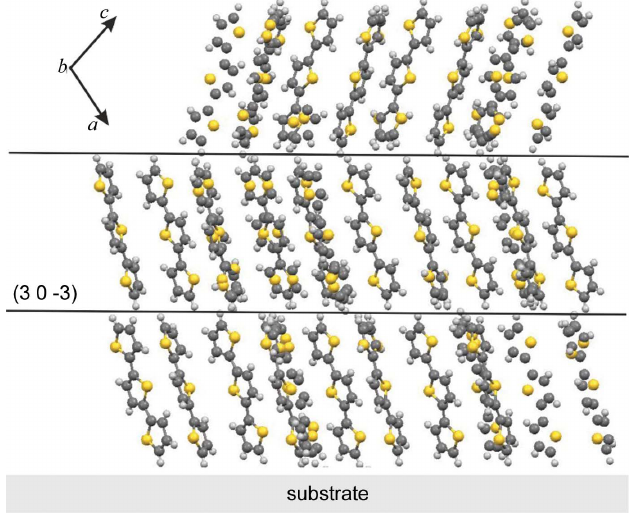
Figure 4 Arrangement of terthiophene molecules relative to the substrate surface within the surface-confined phase in a front view projected along the b axis. The crystallographic plane (30 (cid:4) 3) is arranged parallel to the substrate